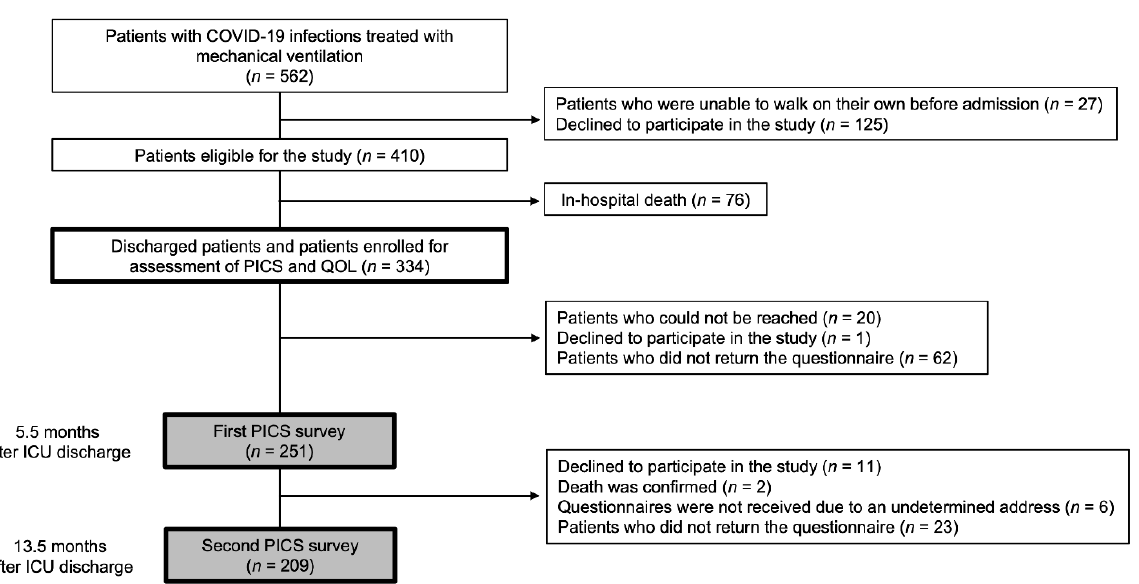
Figure 1. Study outline. Flowchart depicting the enrollment of subjects in the study. COVID-19: coronavirus disease 2019; ICU: intensive care unit; PICS: post-intensive care syndrome; QOL: quality of life.